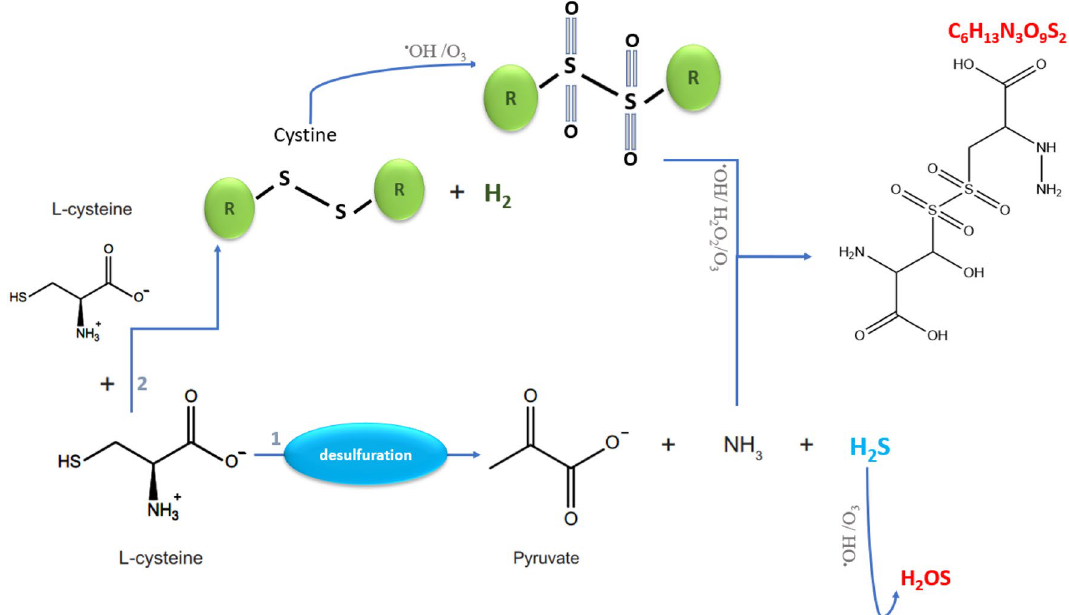
Figure 10. Predicted pathway of two bioproducts: ( 1 ) H 2 OS (m/z = 50 Da) and ( 2 ) C 6 H 13 N 3 O 9 S 2 (m/z = 336